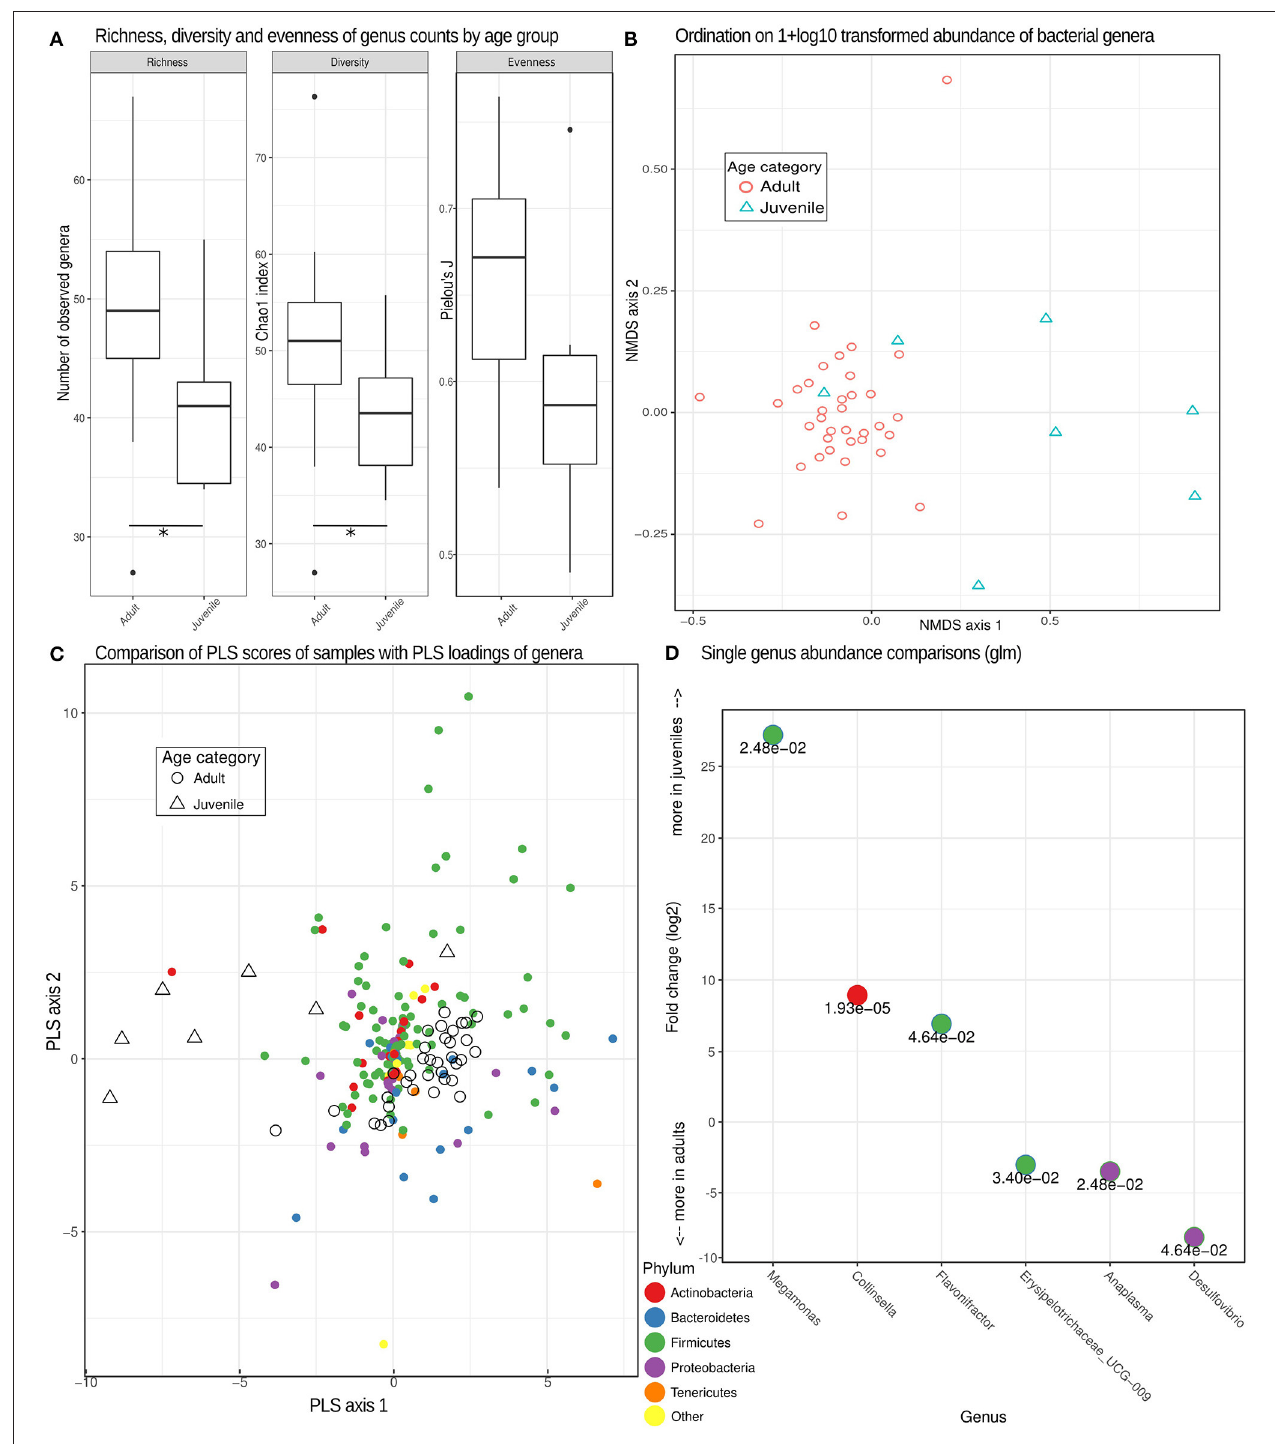
FIGURE 3 | Bacterial genera richness, diversity and microbiome composition in different age categories. (A) Box plots depicting distributions of richness (observed counts of genera richness per phylum), diversity (Chao1 index) and evenness (Pielou’s J ) estimates on rarefied (see methods) genera counts for juveniles and adults. *Significant differences ( p < 0.05) based on exact Mann-Whitney U tests. (B) Non-metric multidimensional scaling (MDS) ordination based on pairwise Bray-Curtis dissimilarities partially separated juvenile from adult samples based on different compositions of taxonomic units. (C) A comparison of PLS scores (for samples) and PLS loadings (for genera) from the first two PLS axes of an optimized partial least squares model, demonstrating a clear separation of adult and juvenile samples. Genera colored by phylum can be used to assess the taxa contributing (PLS loading) to the differences underlying this distinction. (D) Log2-fold change inferred by generalized linear models testing for differences between adults and juveniles for each genus with a false discovery rate (adjusted p -value) of < 0.05. The numerical value of the false discovery rate is given below the dot for each genus color-coded for its respective phylum.